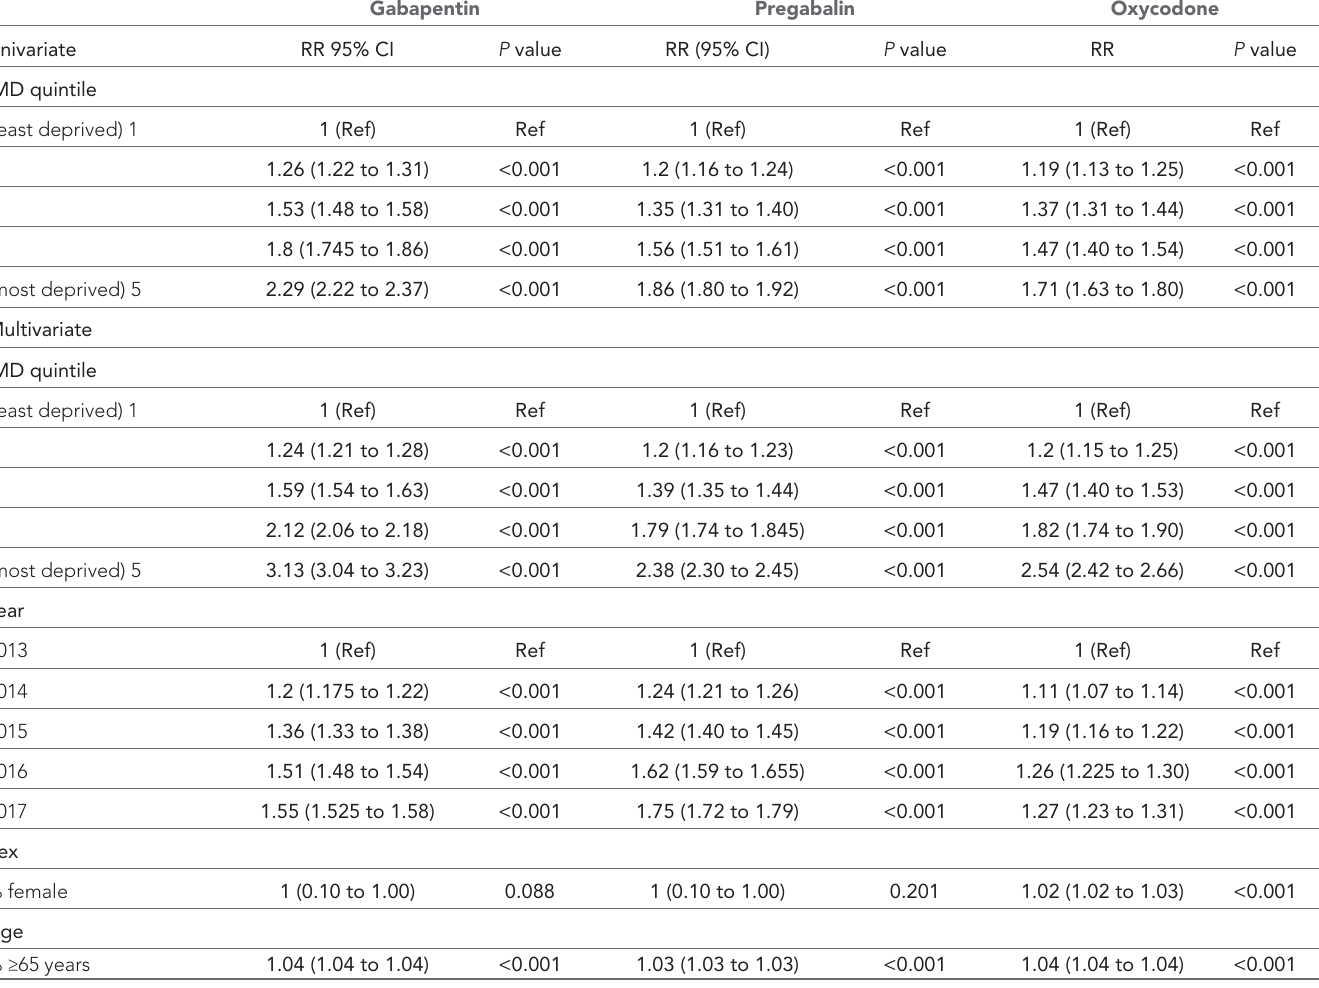
Table 3 Association between number of prescriptions per person per GP practice and GP practice IMD